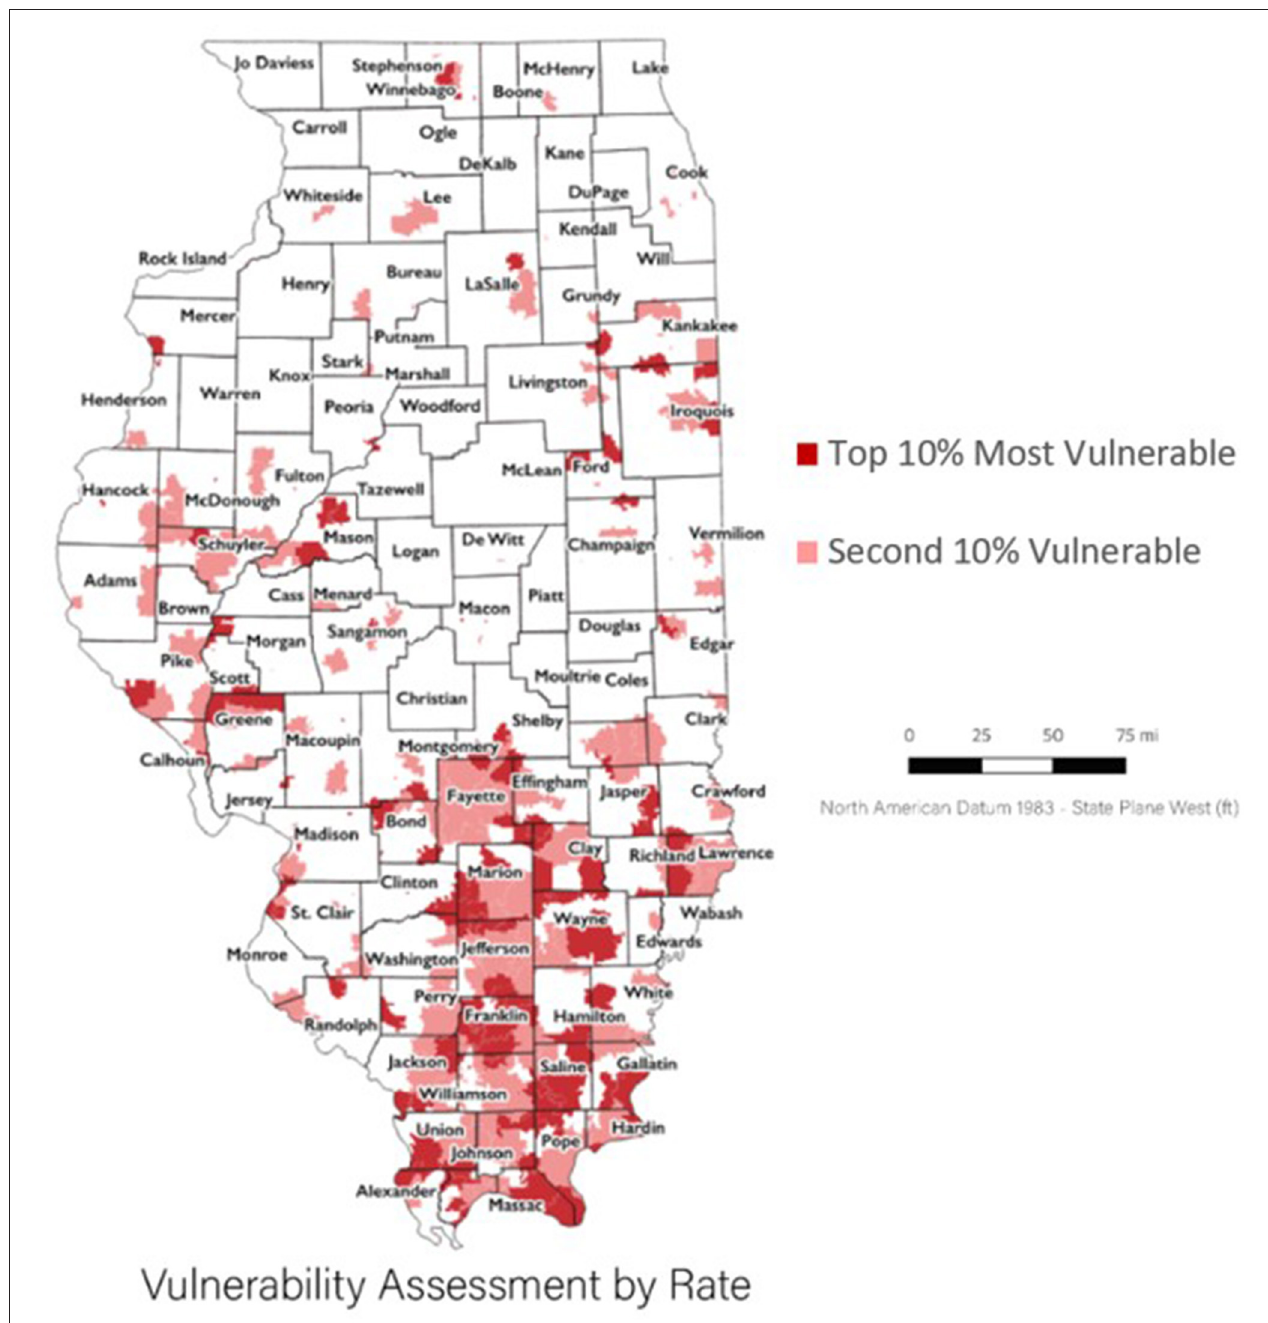
FIGURE 1 | Illinois vulnerability assessment by